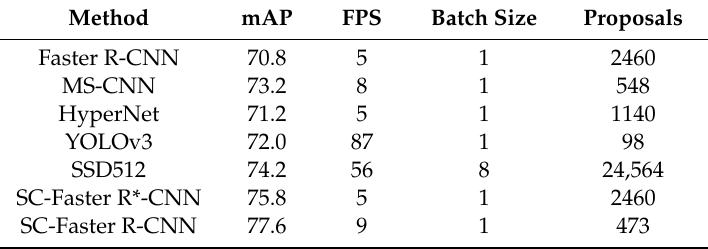
Table 5. Important performance indicators of each algorithm when testing on 07 + 12